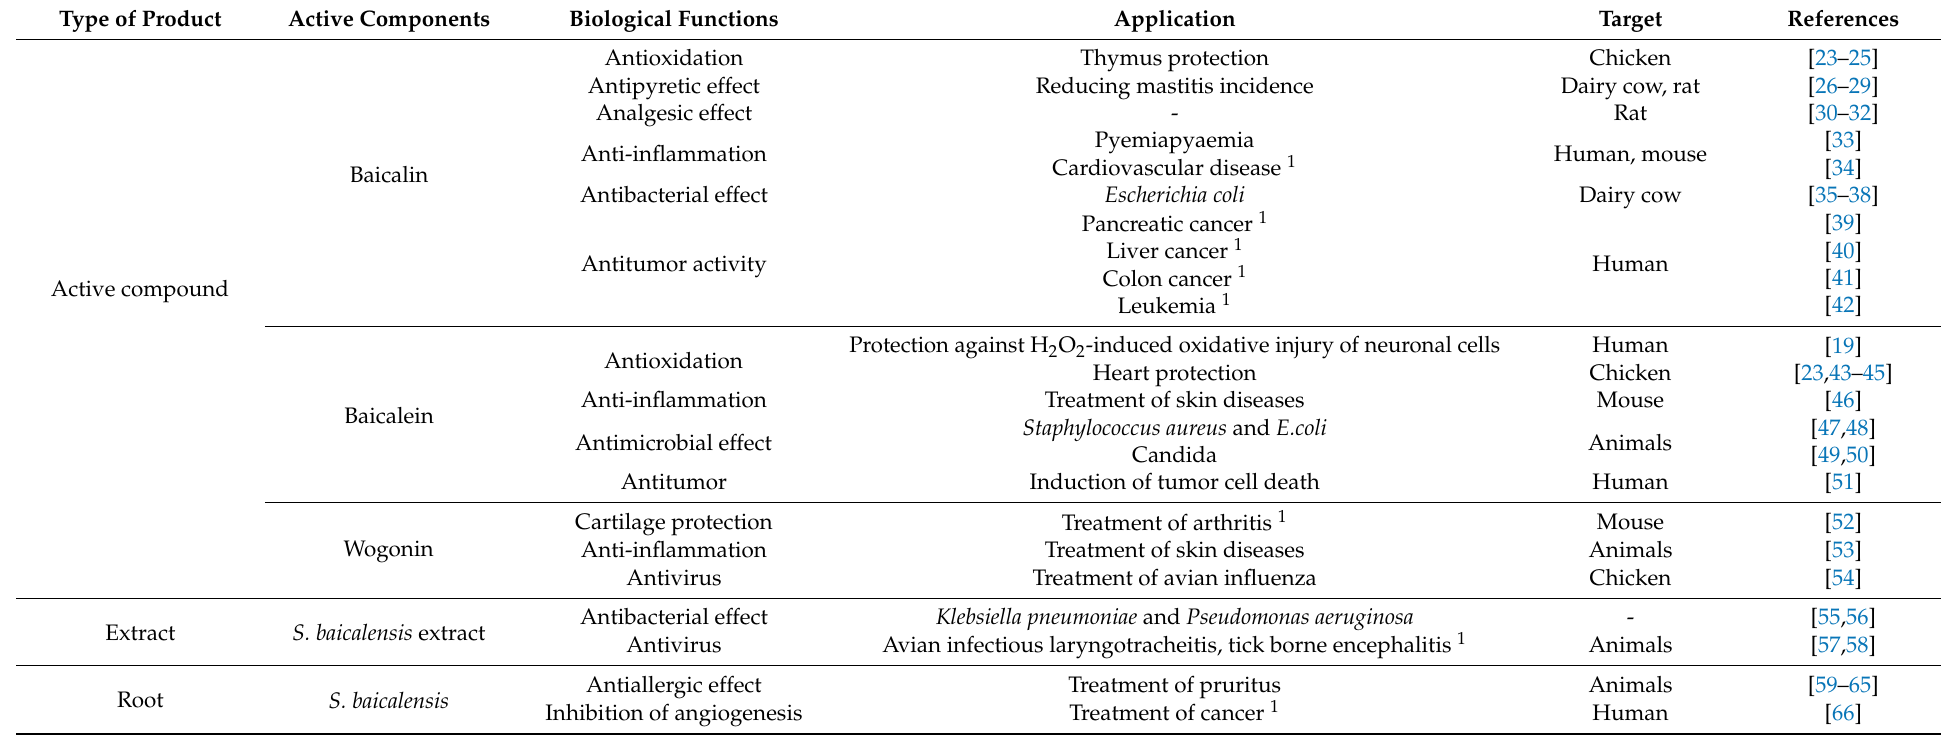
Table 1. The biological functions and application of Scutellaria baicalensis and its active